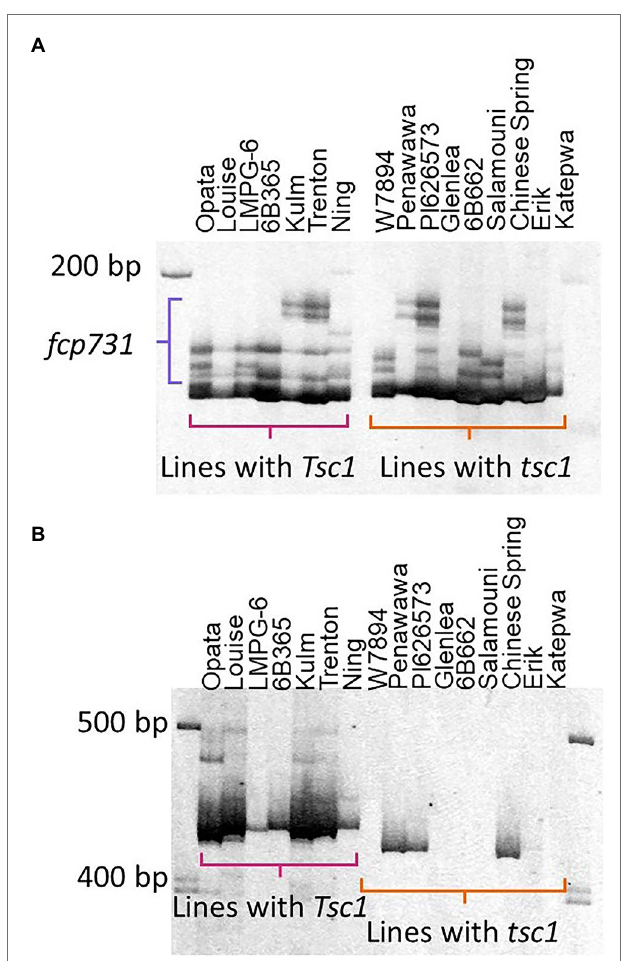
FIGURE 5 | Evaluation of markers cosegregating with Tsc1 . The polyacrylamide gel images of markers fcp731 (A) and fcp732 (B) run on lines with known sensitivity statuses ( Table 1 ) are shown. Horizontal brackets in pink and orange denote amplicons in lines with Tsc1 and tsc1 , respectively. The primary amplicon was scored for marker fcp732 (B) . The amplicons denoted by the purple bracket were scored for marker fcp731 (A)